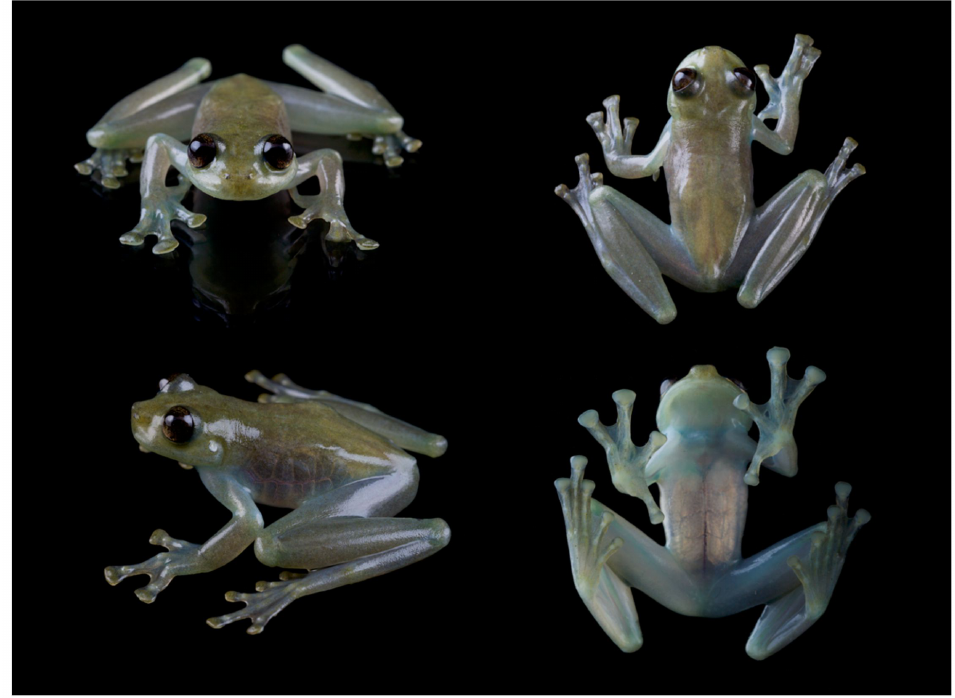
Figure 205. Sachatamia orejuela in life. Adult male, QCAZ 45993. Locality near R í o Aguas Verdes, 670 m, Imbabura province, Ecuador. Photos by Luis A.